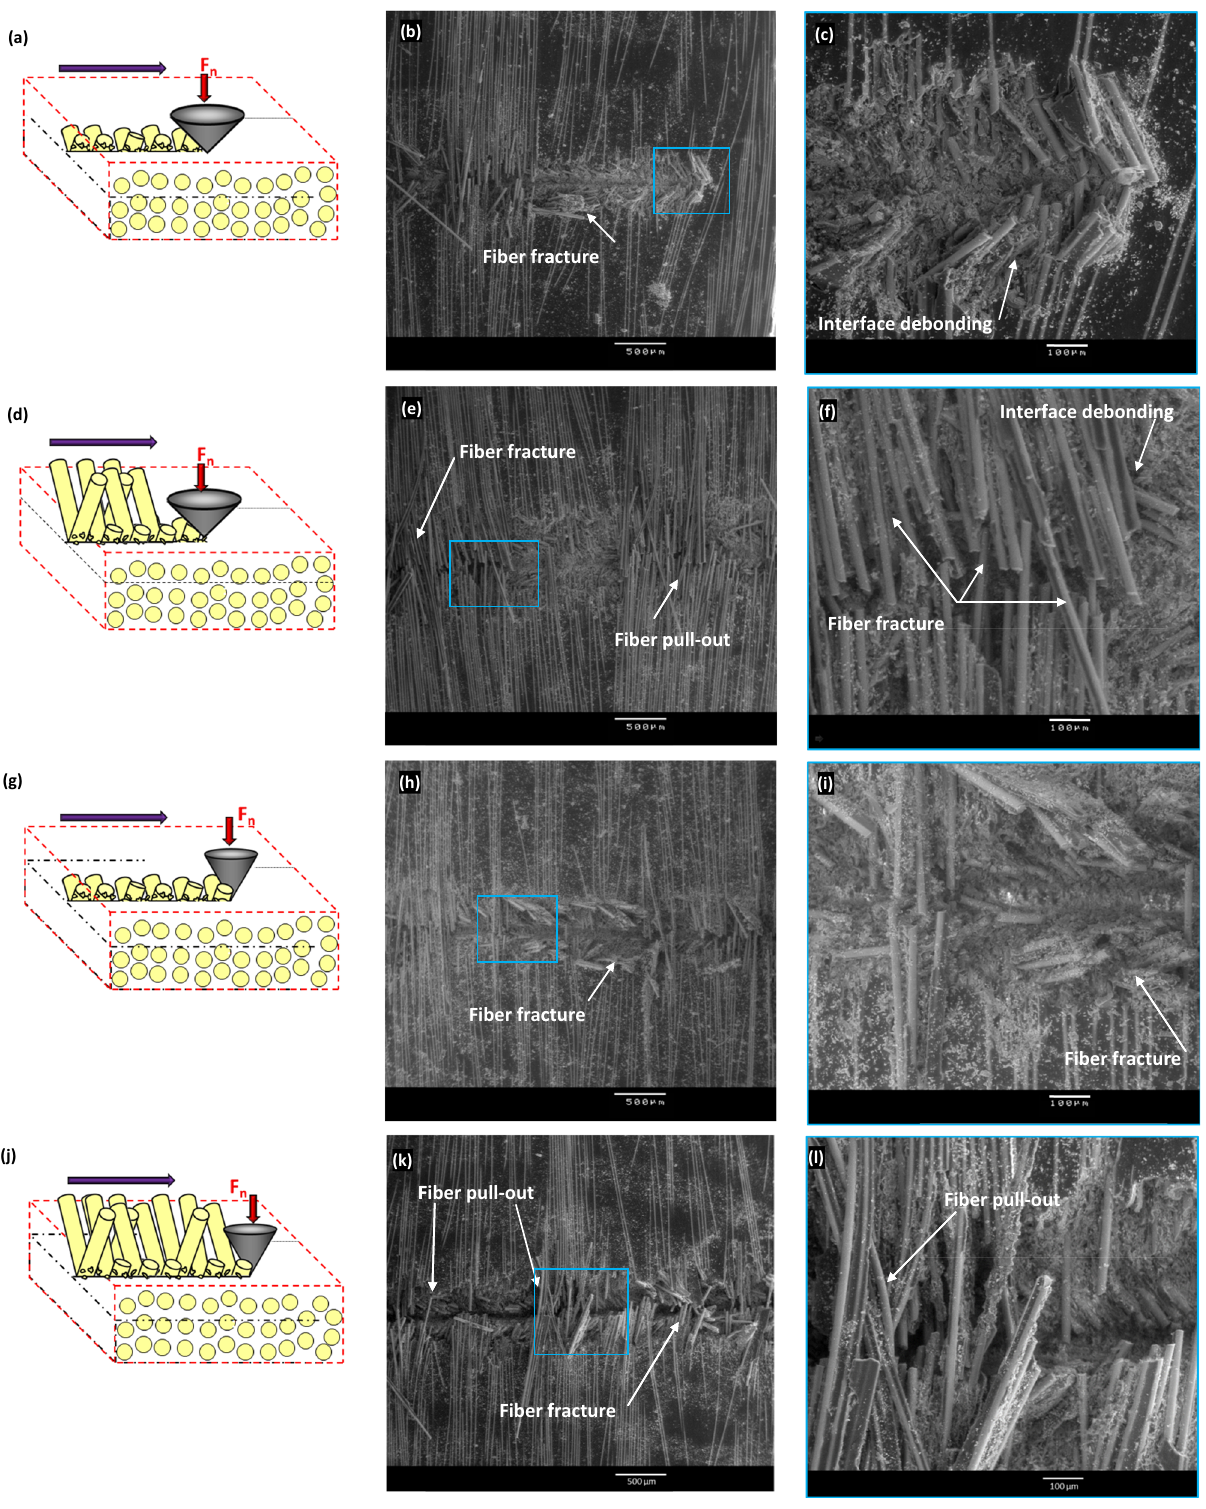
Figure 5: Wear scenarios and SEM micrographs emphasizing the SST ⊥ wear mechanisms. ( a – c ) θ = 45° − F n = 20 N, ( d – f ) θ = 45° − F n = 50 N, ( g – i ) θ = 60° − F = 20 N, and ( j – l ) θ = 60° − F = 50 n n